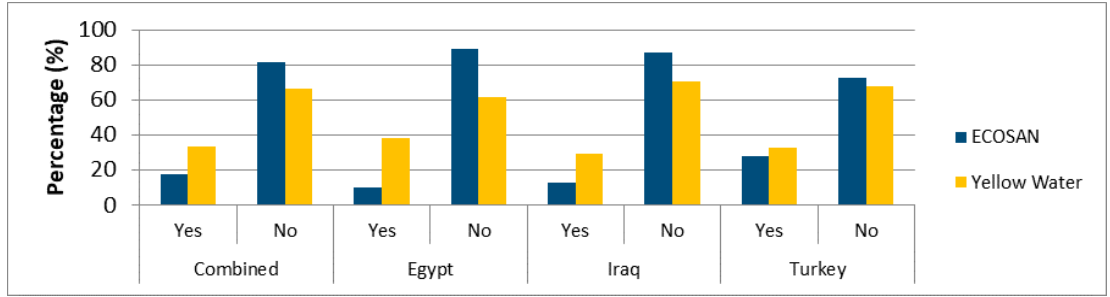
Figure 1. Knowledge about “ECOSAN/Segregated Streams” and “Yellow Water”